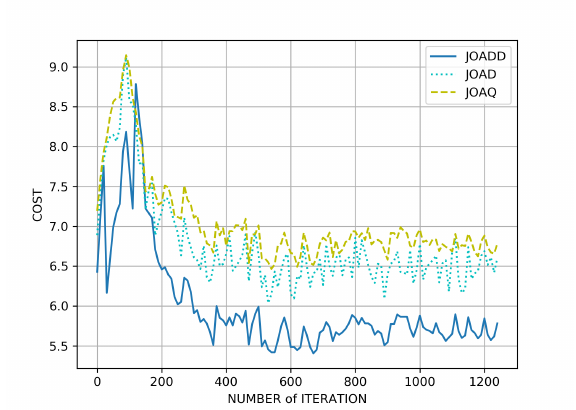
Figure 5. The convergence of different